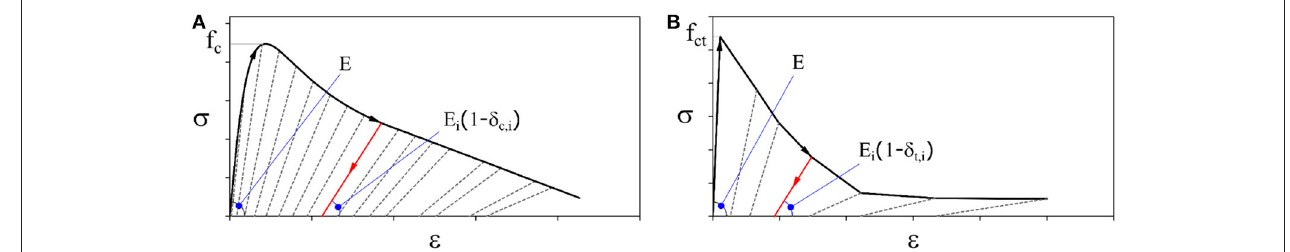
FIGURE 1 | Example of mechanical model for concrete in compression (A) and tension stiffening (B)